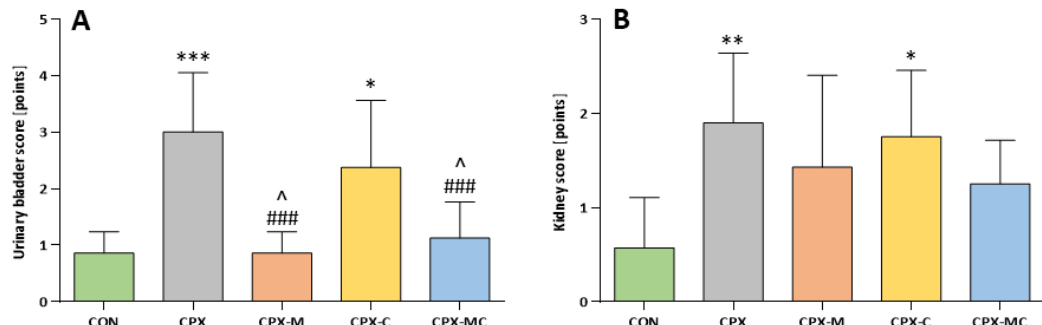
Figure 5. Urinary bladder score ( A ) and kidney score ( B ) based on histological injuries evaluation. The scoring system is presented in the Materials and Methods section. A detailed description of experimental groups is presented in Figure 1 and the Materials and Methods section. * p < 0.05, ** p < 0.01, *** p < 0.001 vs. CON group; ### p < 0.001 vs. CPX group; ^ p < 0.05.